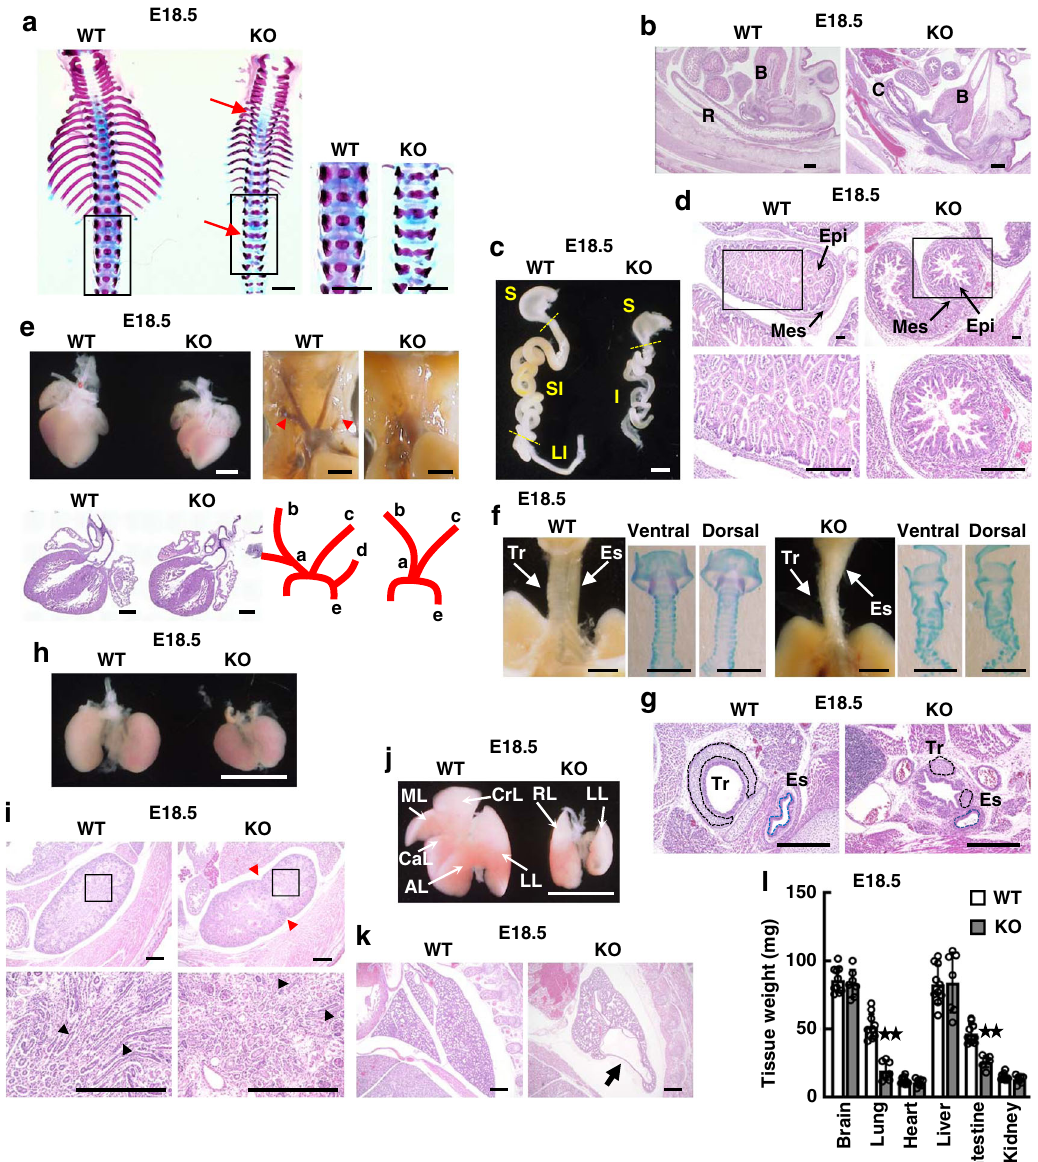
Fig. 2 Dyrk2 − / − embryos exhibit congenital malformations in multiple organs. Dyrk2 − / − mice exhibit vertebral, intestinal/anorectal, cardiac, trachea, esophageal, renal, and lung development. a Spine defects of E18.5 embryos. Red arrows; the lack of vertebral bodies and butter fl y vertebrae. b H&E staining of the anus and cloaca in E18.5 embryos. B bladder, R rectum, C cloaca. c Gross morphology of intestine in E18.5 embryos. S stomach, SI small intestine, LI large intestine, I intestine. d H&E staining of intestine in E18.5 embryos. Epi epithelium, Mes mesenchyme. e Gross morphology and H&E staining of the heart and cardiac out fl ow tract in E18.5 embryos. Red arrowheads; the left and right subclavian arteries. Insets in each frame is a schematic of the aortic arch with the aorta and tributaries. a ascending aorta, b brachiocephalic artery, c left common carotid artery, d left subclavian artery, e descending aorta. f Gross morphology of trachea (Tr) and esophagus (Es), and alcian blue staining of cartilaginous rings in E18.5 embryos. g H&E staining of trachea (Tr) and esophagus (Es) in E18.5 embryos. Dashed black lines; cartilaginous rings. Dashed blue lines; esophagus. h Gross morphology of kidneys in E18.5 embryos. i H&E staining of kidneys in E18.5 embryos. Red arrowheads; the lobe folds. Black arrowheads; medullary collecting ducts. j Gross morphology of lungs in E18.5 embryos. AL accessory lobe, CaL caudal lobe, CrL cranial lobe, ML medial lobe, LL left, RL a one-lobed right lung. k H&E staining of lungs in E18.5 embryos. Black arrow; lung cysts. l Tissue weight of E18.5 embryos. Data are presented as the mean ± SD (WT: n = 10; KO: n = 7; ** p < 0.01). Scale